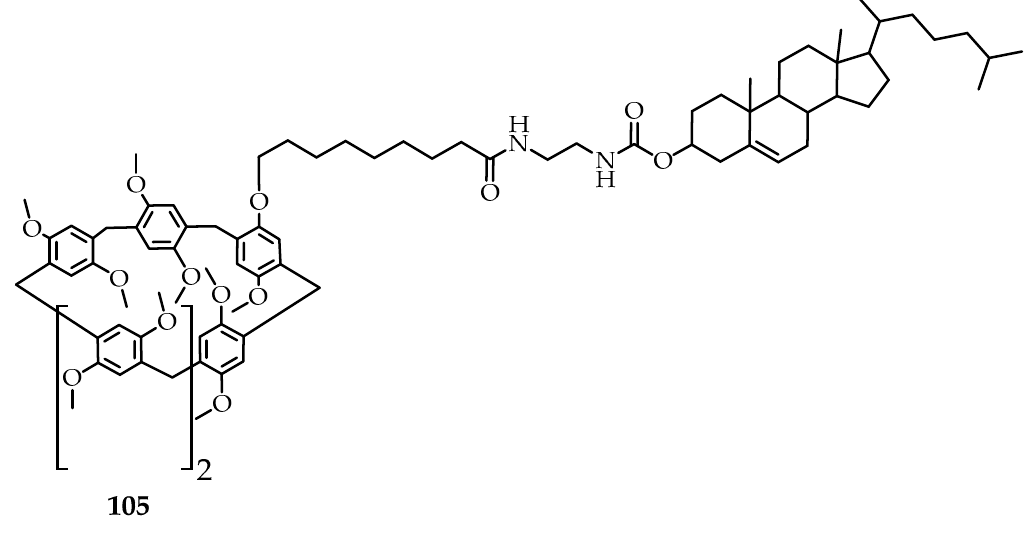
Figure 12. Structure of pillar[6]arene 105 .